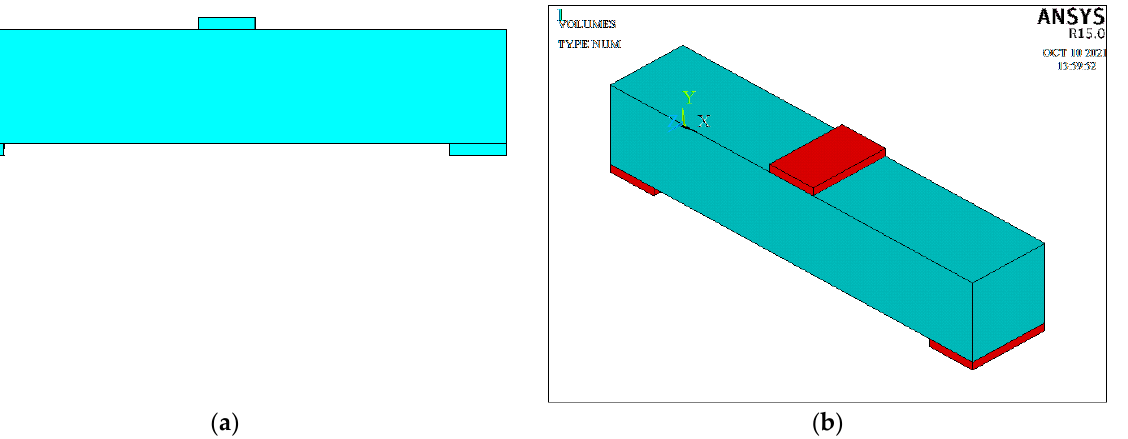
Figure 4. Details of a typical beam model: ( a ) Front view of the beam model, ( b ) 3D view of the solid beam model.